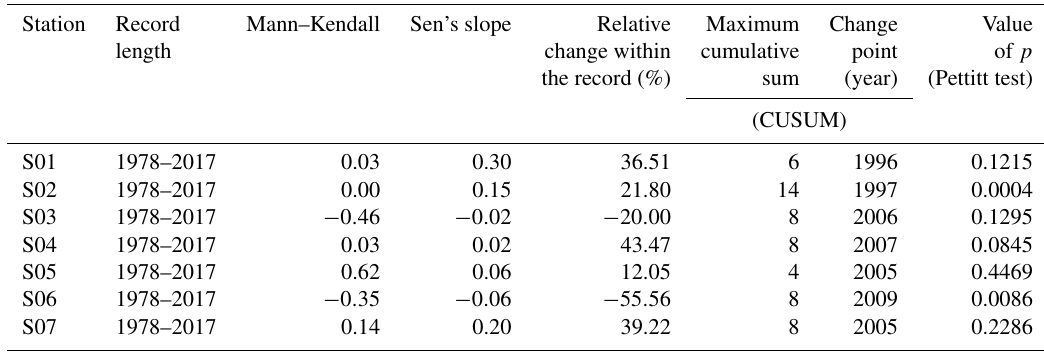
Table 4. Trend analysis for time series period.